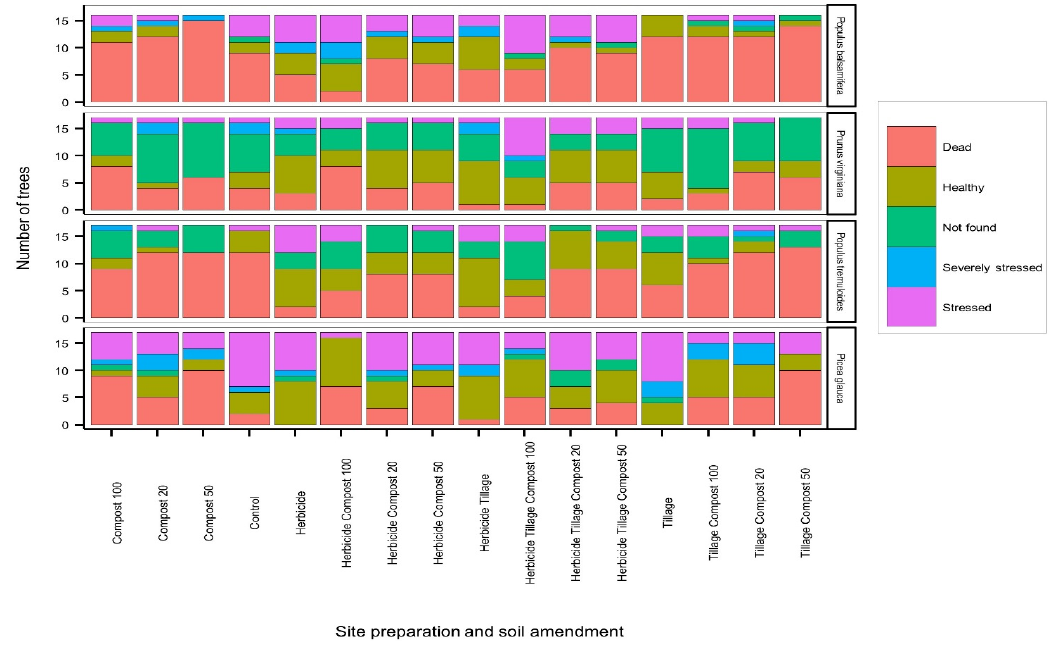
Figure 1. Number of individual tree species by health categories based on site preparations and soil amendments.